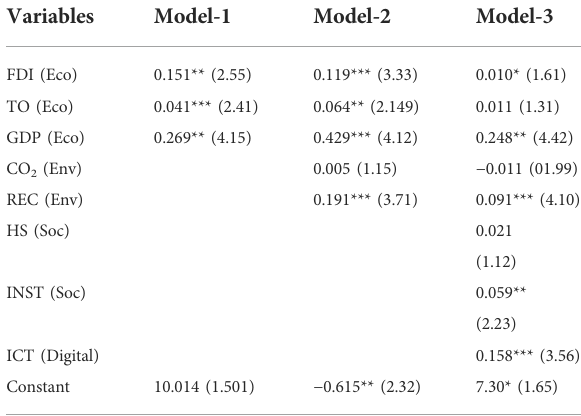
TABLE 5 Empirical results of panel SSA from FGLS